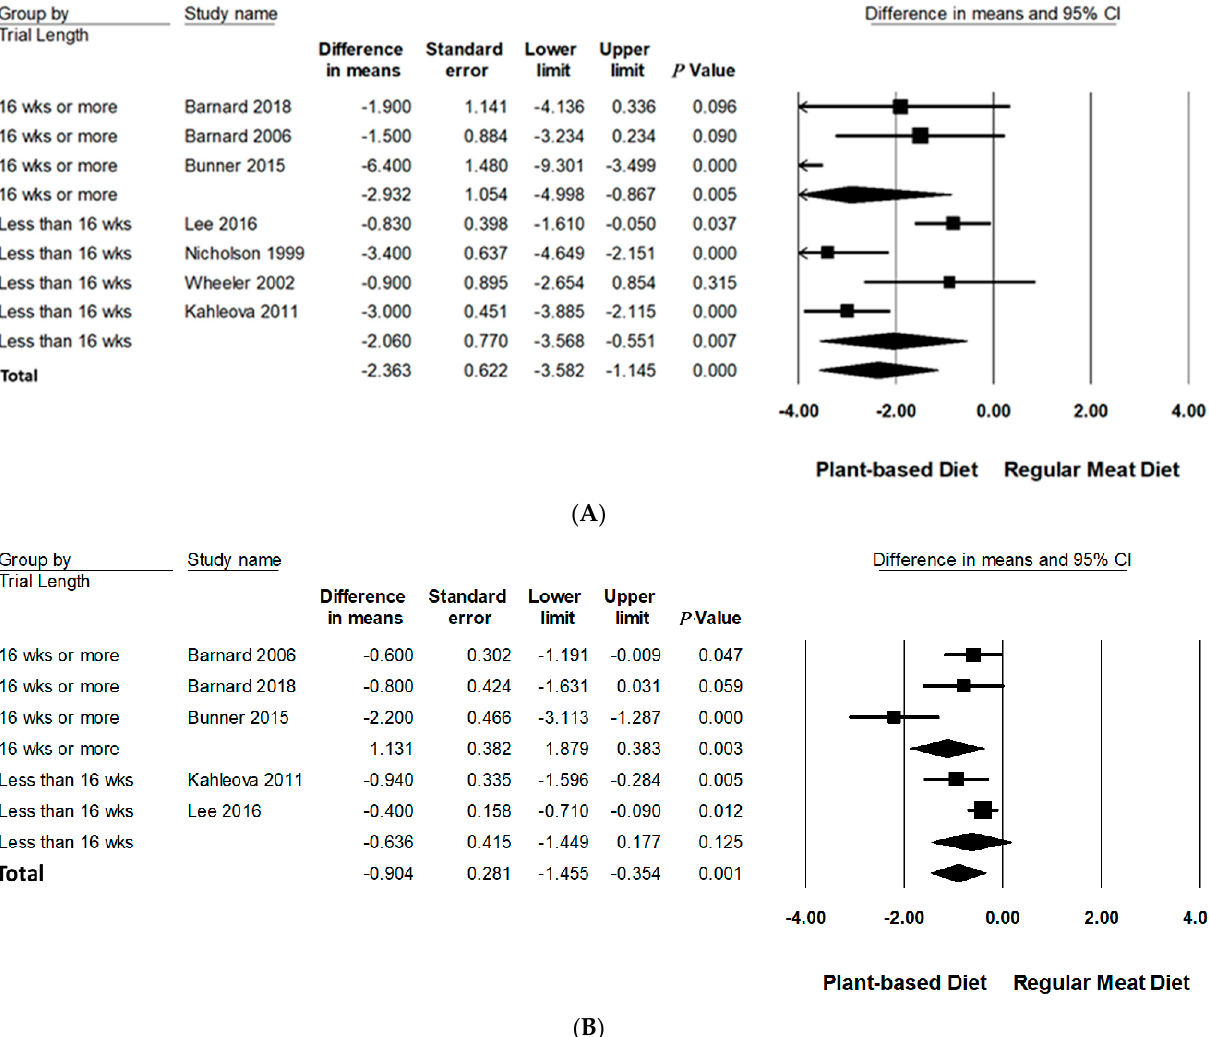
Figure 4. Forrest plots displaying difference in mean (MD) and 95% CI for the impact of trial length (weeks) of PBDs compared to RMDs on ( A ) body weight (kg) [29–35] and ( B ) BMI (kg/m 2 ) [29,30,32–34].